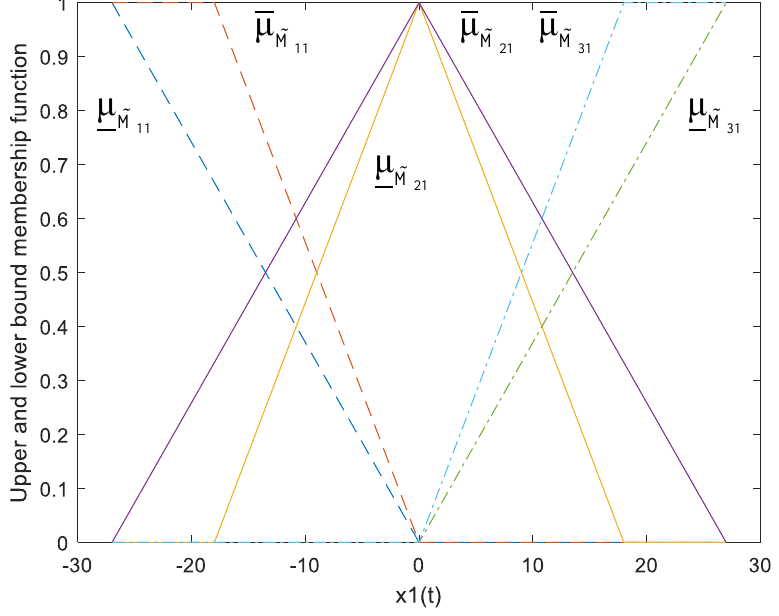
Figure 2. IT-2 membership function of boiler system.